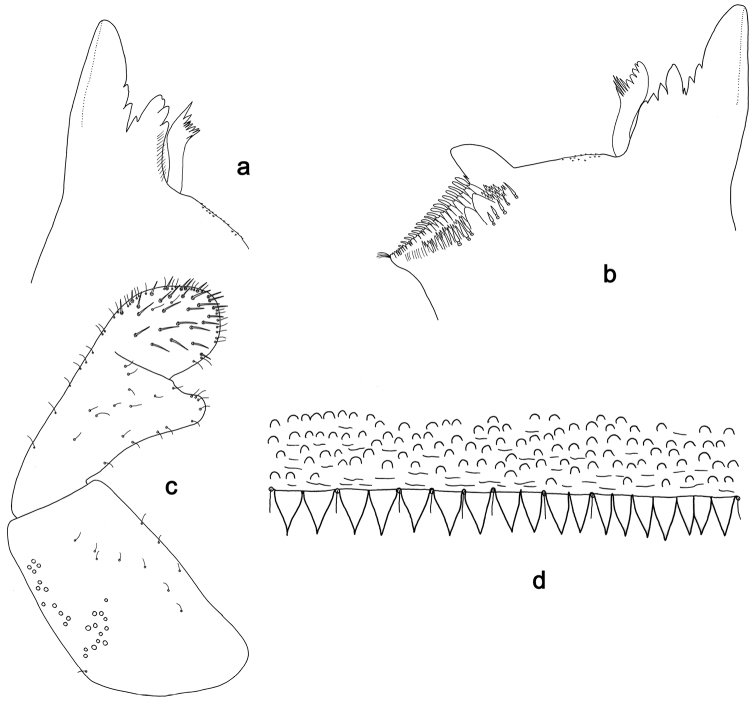
Labiobaetispetersorum, larva morphology: a Right mandible b Left mandible c Labial palp dTergum IV.